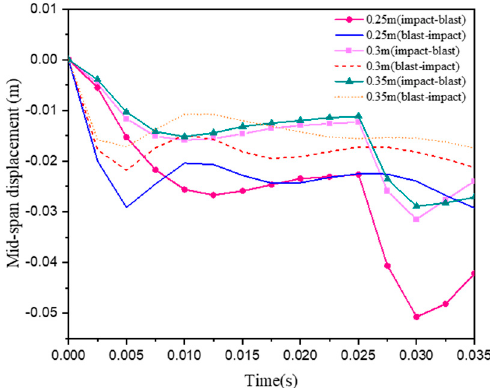
Figure 12. Time-history curves of mid-span displacement of beams under different beam depths.